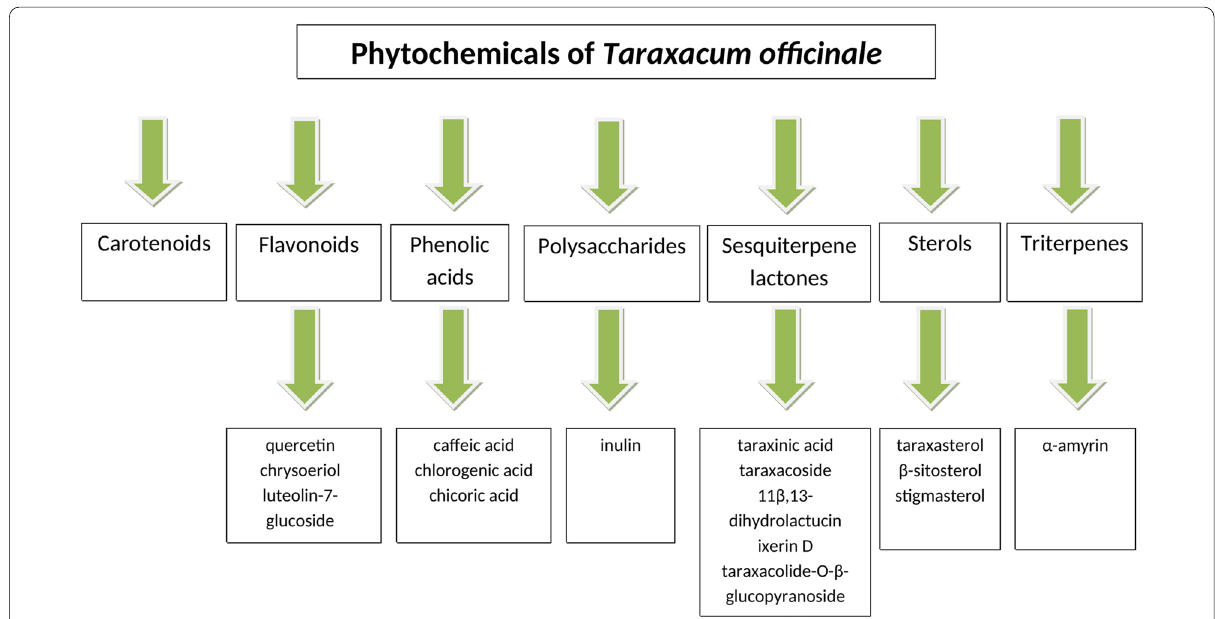
Fig. 2 Main phytochemicals of Taraxacum officinale . The diagram shows the main chemical components of Taraxacum officinale